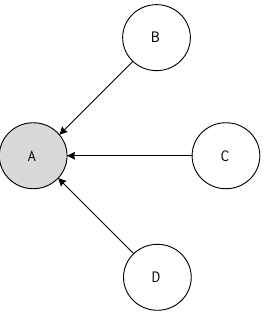
Fig. 1: Activation of target vector (cid:126)x G node A ) by the solution vectors (cid:126)x G r (cid:126)x G r (represented by nodes B , C and D ) to move 3 to a better